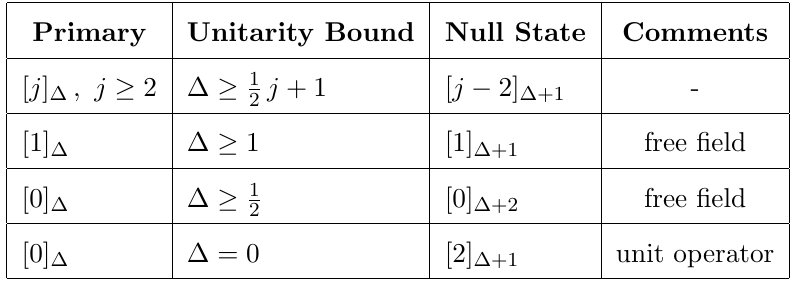
Table 25 . Unitary representations of the conformal algebra in d =